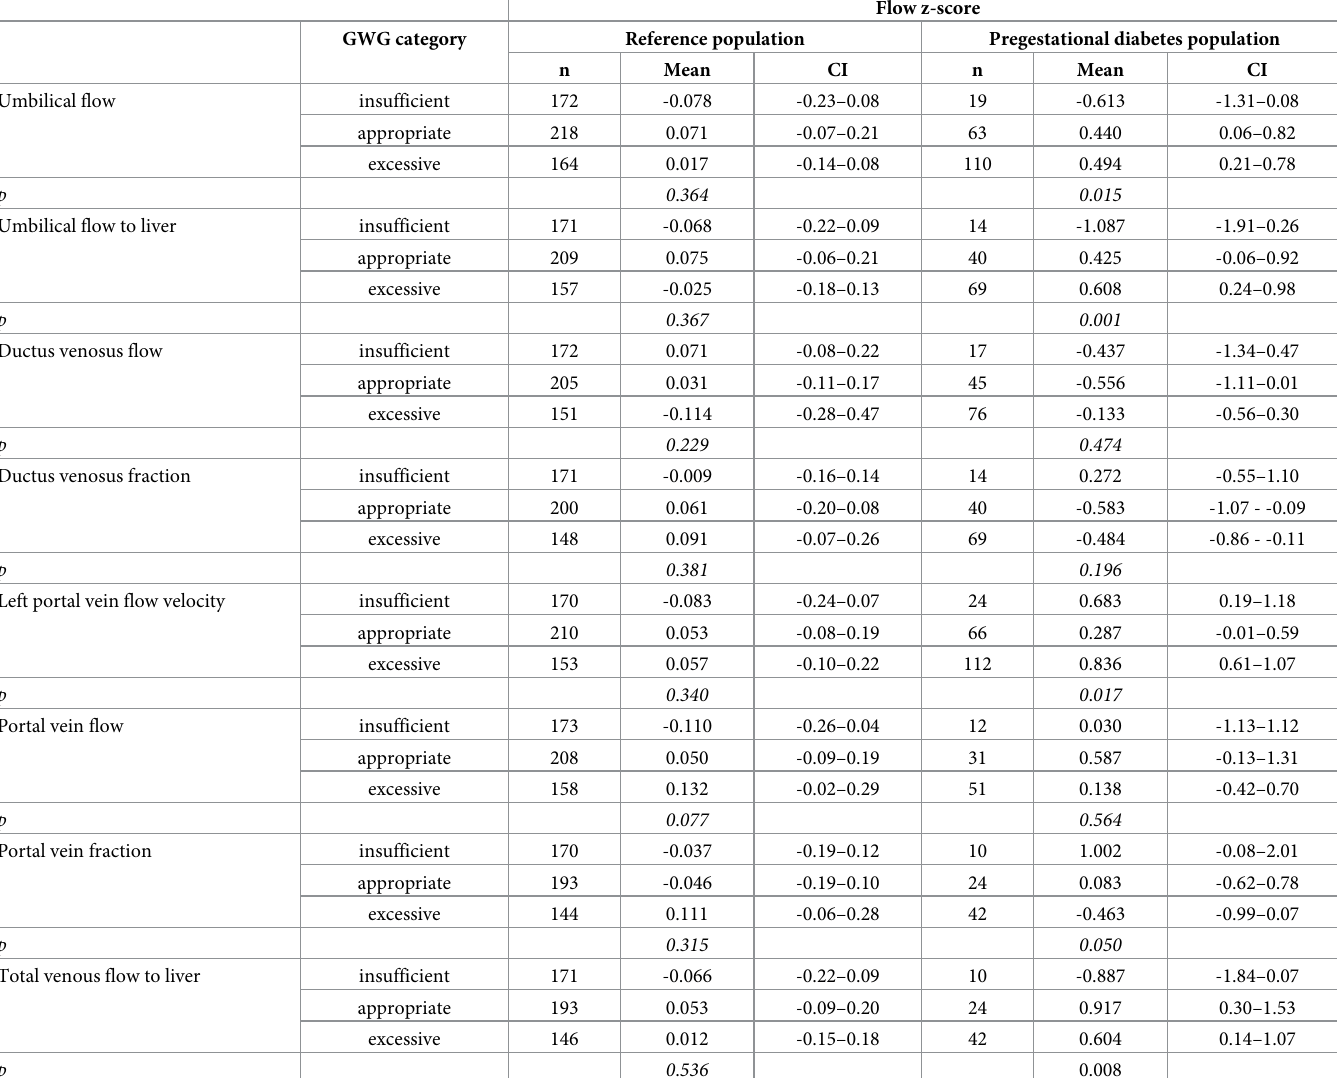
Table 6. Fetal venous liver flow according to gestational weight gain categories in the reference and pregestational diabetes mellitus populations (160 and 49 partic- ipants,